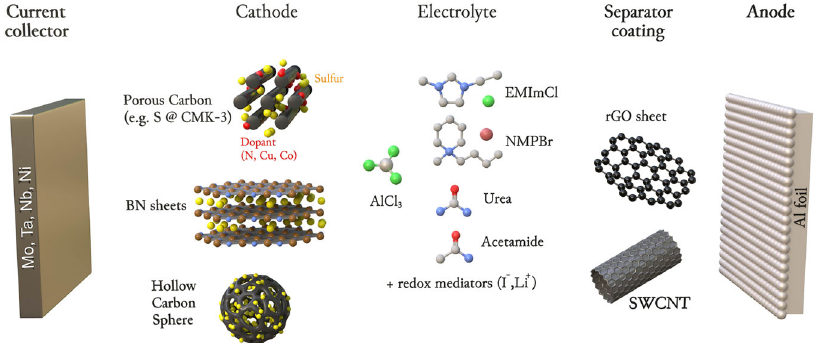
Fig. 3 Common materials of state-of-the-art Al-S batteries. The illustration of the common materials used for the fabrication of Al – S batteries.